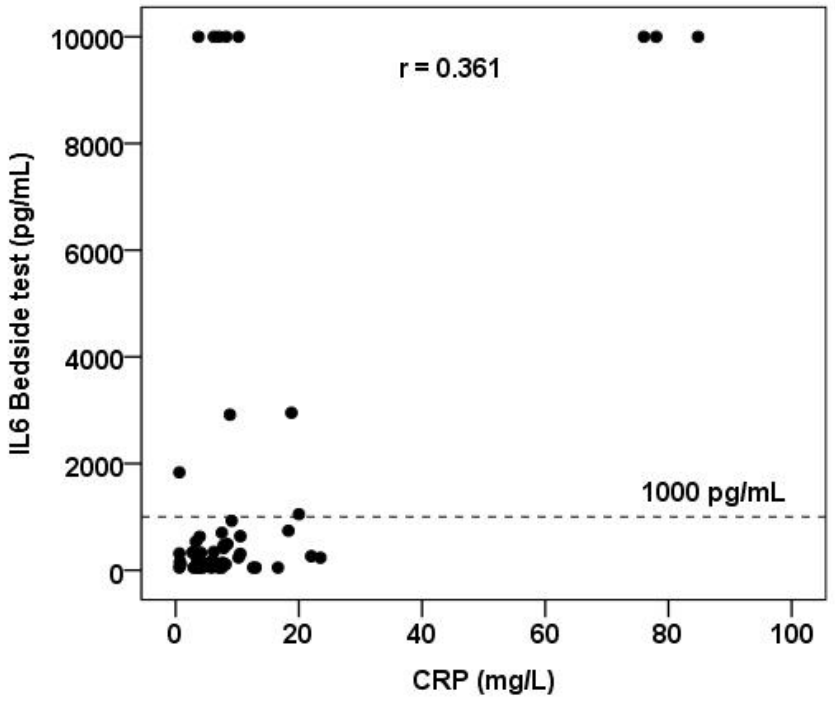
Fig. 4. Correlation between maternal CRP and IL-6 point-of-care test in women with